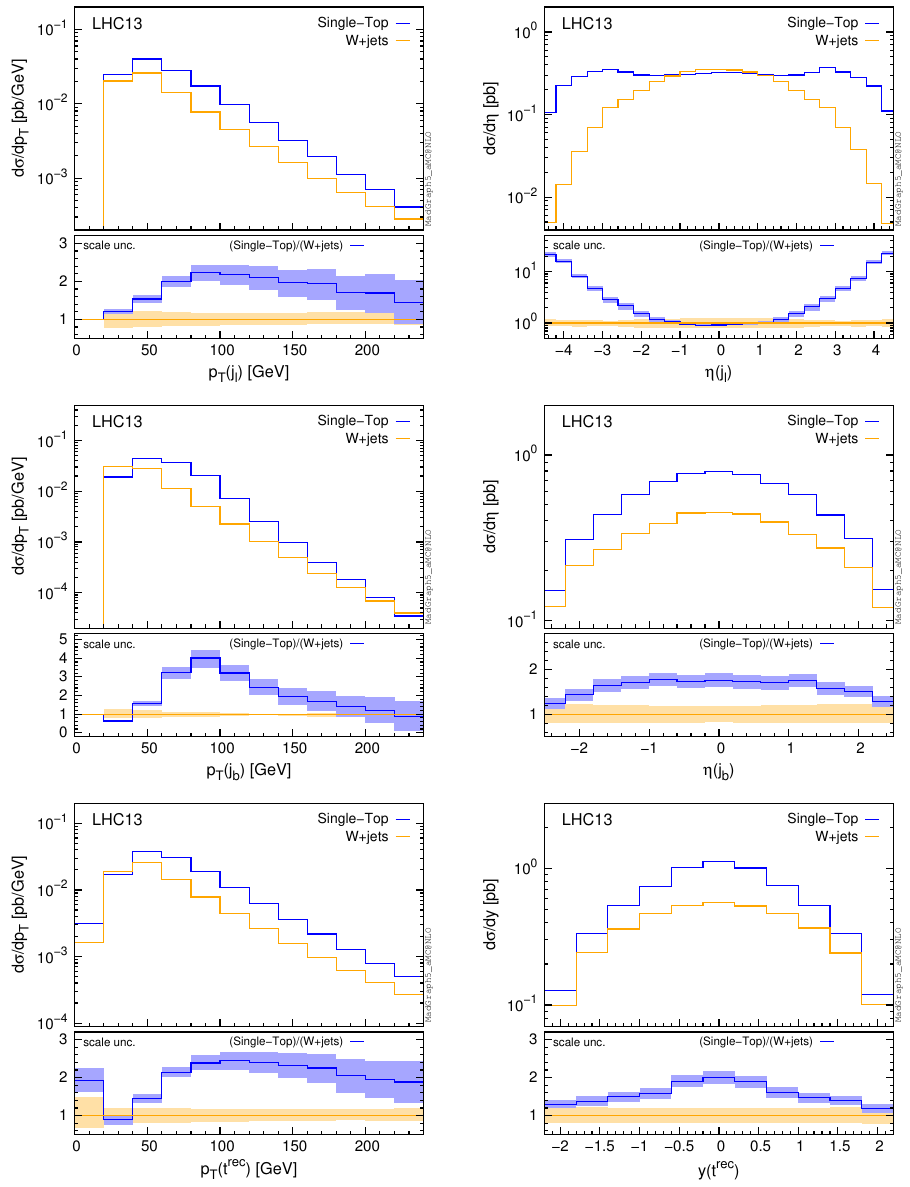
Figure 5 . Comparison between Single-Top and W +jets predictions at NLO QCD+EW accuracy for the same observables considered in (cid:12)gure